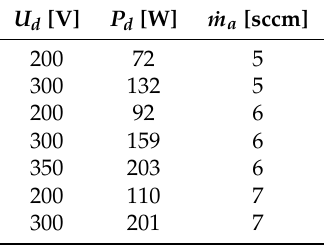
Table 3. Tested operating